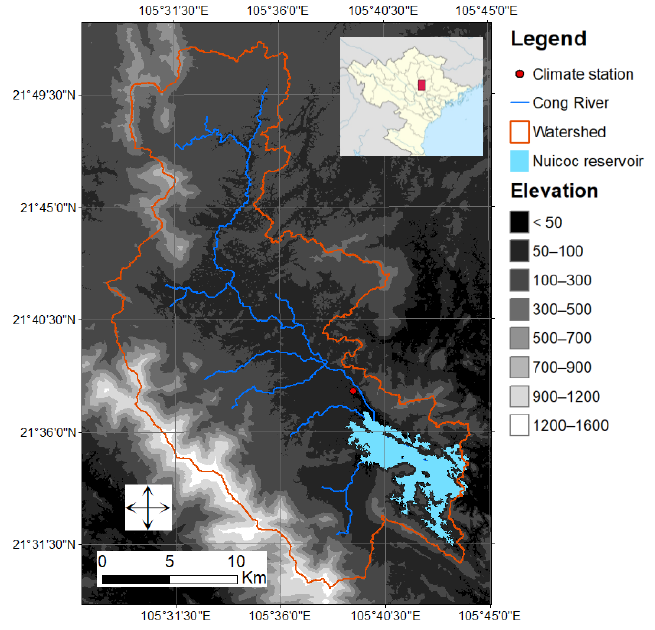
Figure 3. Location of the Nuicoc reservoir and watershed in the Thai Nguyen province of Vietnam. Forests account for 52% of the area, crop cultivation for 30%, rural residential areas